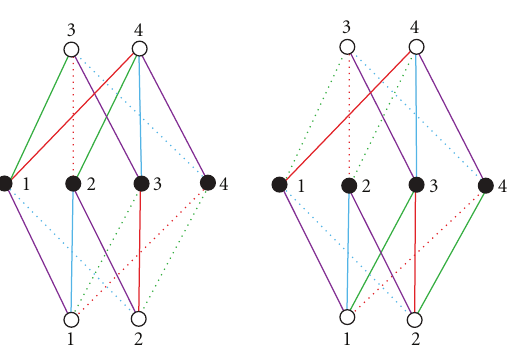
Figure 3: The N (cid:7) 4 2-4-2 Adinkras may be obtained from 3-4-1 Adinkras by raising one vertex. Here we have raised the third boson vertex starting with the two Adinkras shown in Figure